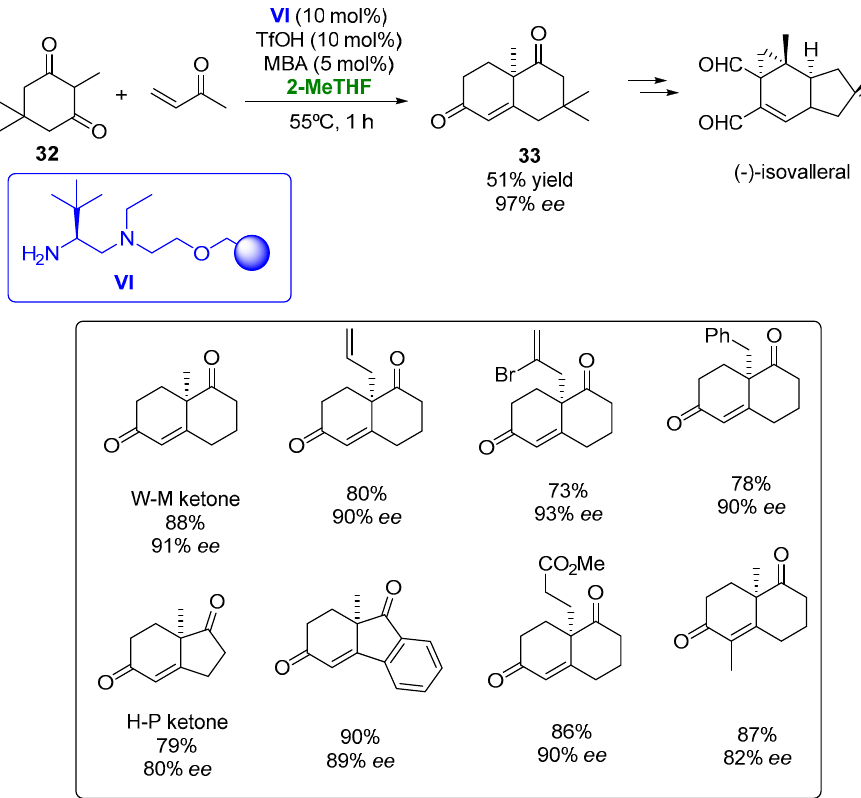
Figure 18. Heterogeneous organocatalyzed preparation of bicyclic diketones employing 2-MeTHF as biobased solvent.